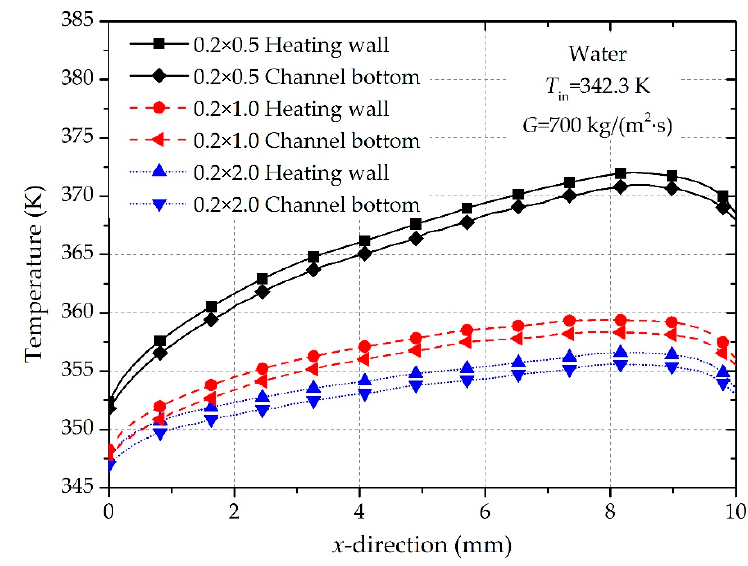
Figure 9. Temperature distribution of the heating wall and channel bottom wall along the flow stream for different channel heights.